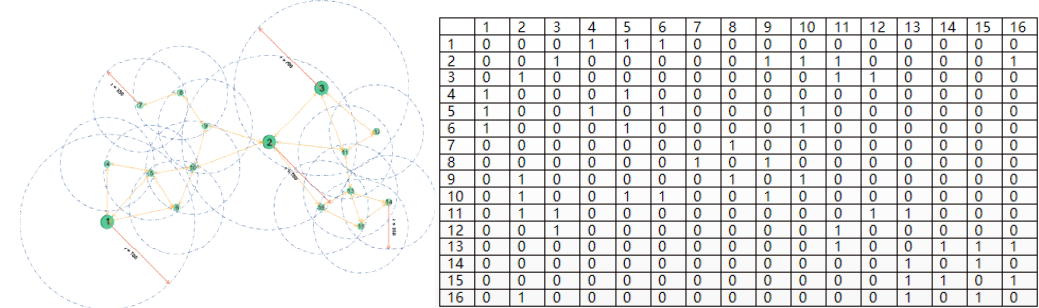
Figure 4. Schematic diagram of the association between public space node accessibility and symmetric collar matrix. Table 2. Assignment criteria for node capacity/activity diversity of public space of sample affordable housing. Node Type